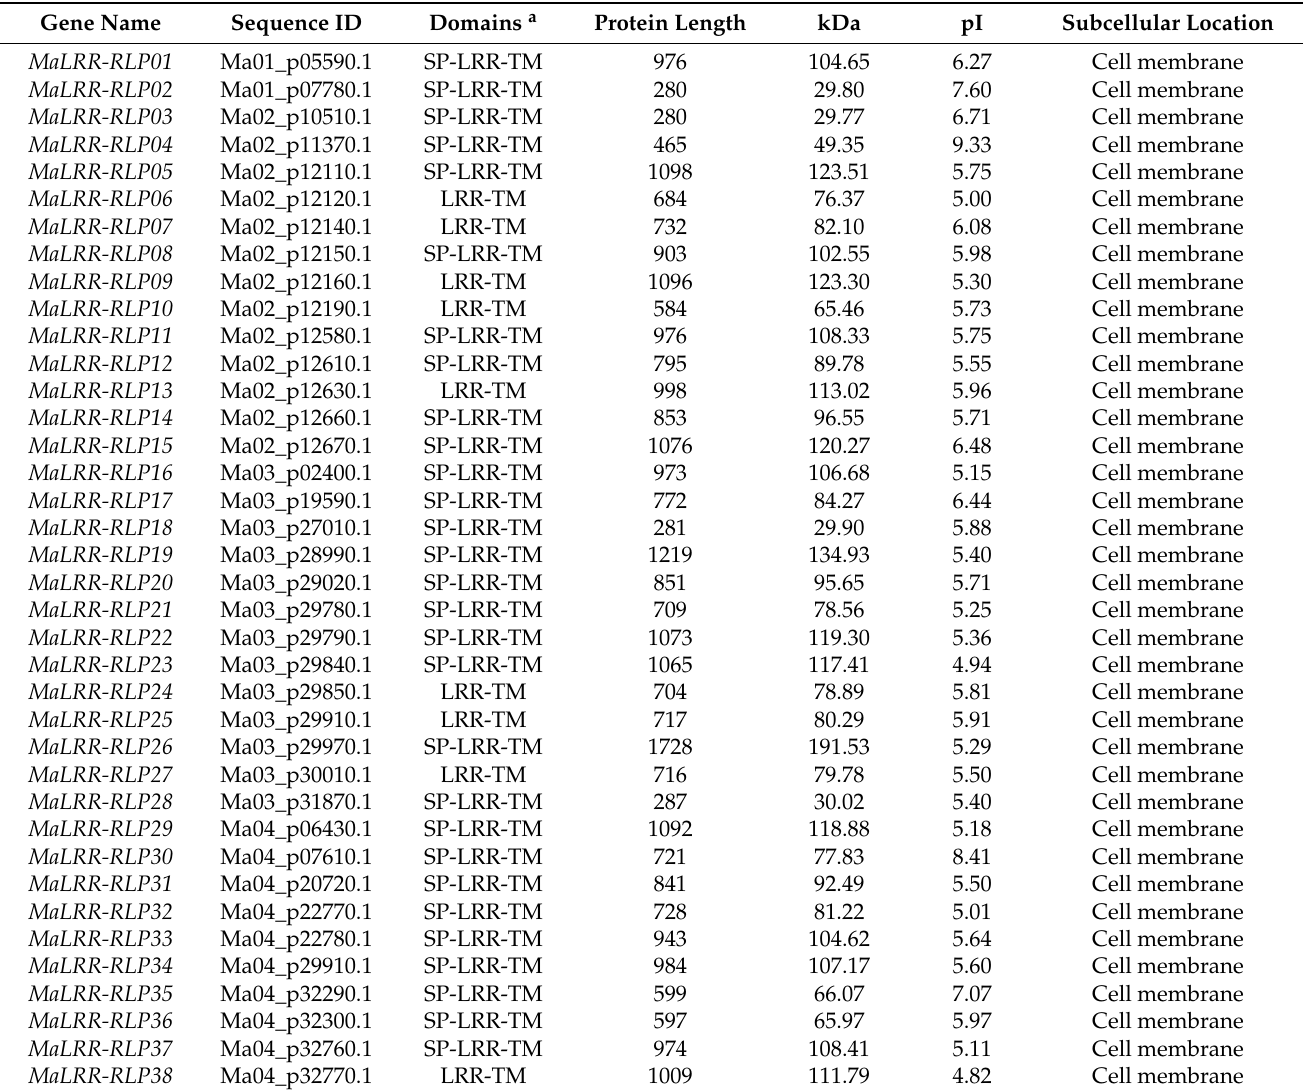
Table 1. Banana LRR-RLP genes identified in this